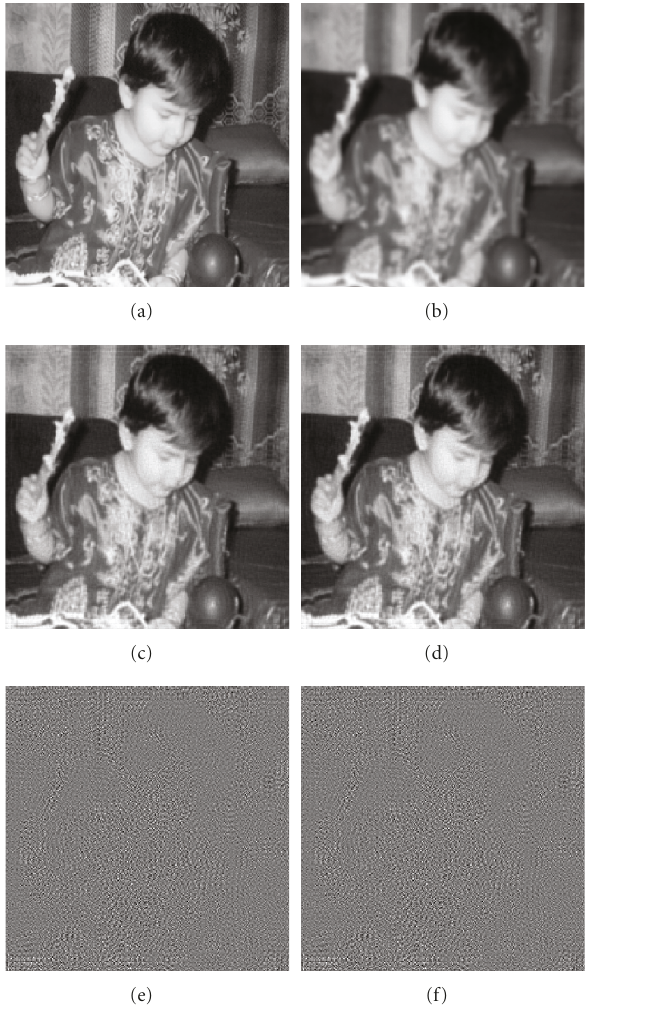
Figure 5: “Anuska” image (a) original image, (b) noisy and blurred image; PSF 5 × 5 Gauss, BSNR = 38.6dB, (c) restored image by MAPE corresponding to maximum SNR (124 iterations), (d) restored image by AAMAPE corresponding to maximum SNR (71 iterations), (e) residual corresponding (c), and (f) residual corresponding (d).